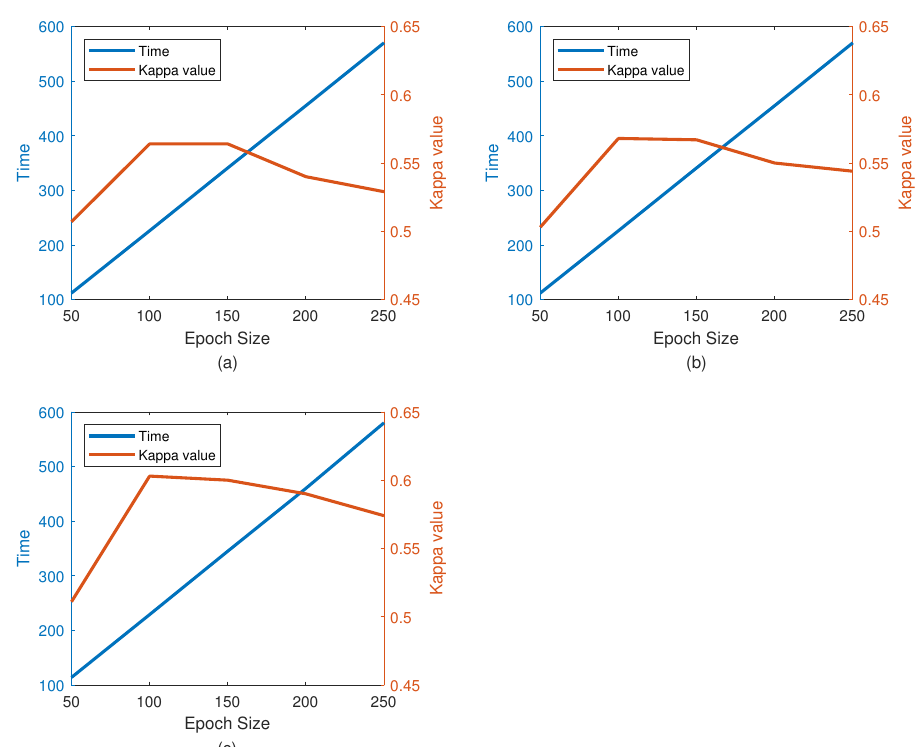
Figure 10. Effect of number of epoch on kappa value and training time. ( a ) The performance on BCI Competition IV dataset 2b; ( b ) The performance on our own dataset with 3 electrodes; ( c ) The performance on our own dataset with 5